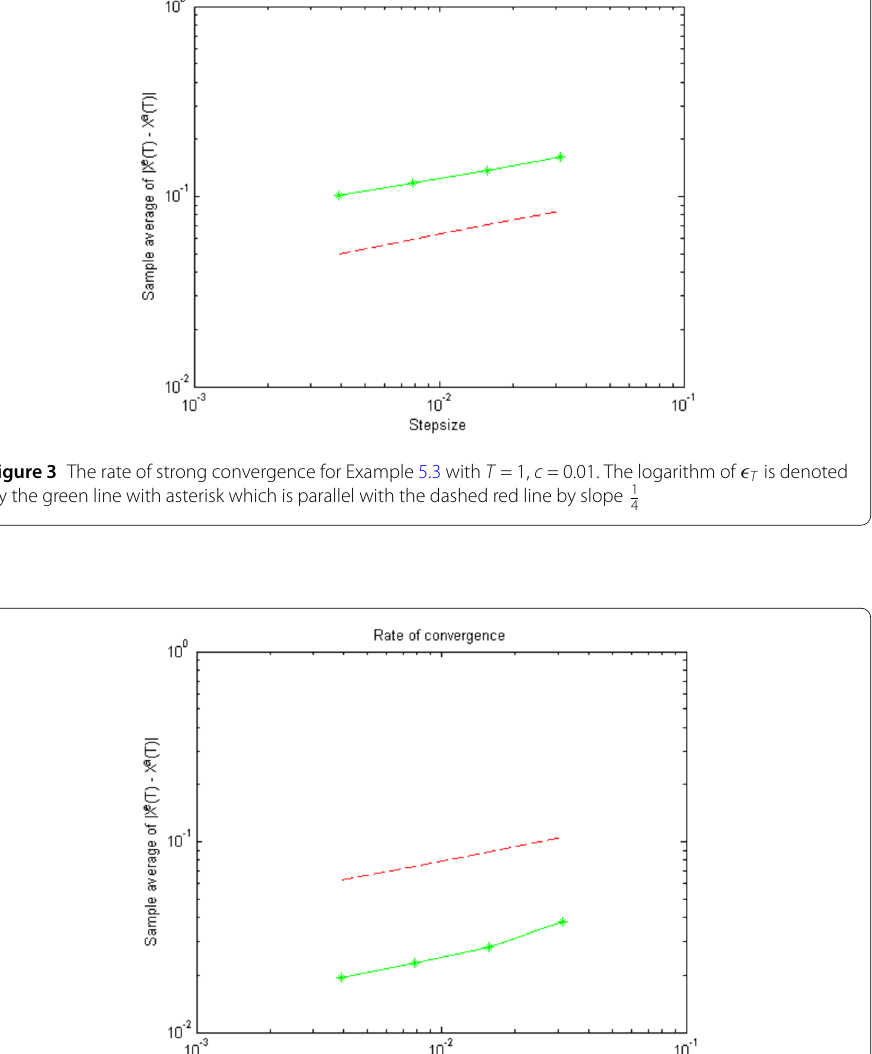
Figure 4 The rate of strong convergence for Example 5.3 with T = 1, c = 1. The logarithm of (cid:14) T is denoted by the green line with asterisk which is parallel with the dashed red line by slope 1